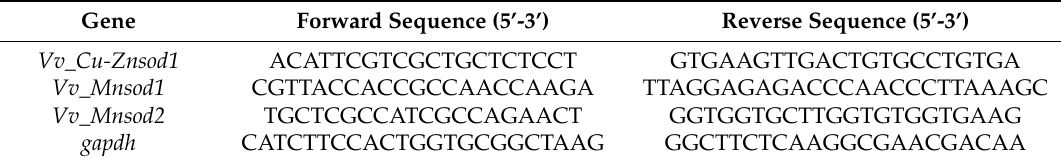
Table 2. Primers used in real-time quantitative